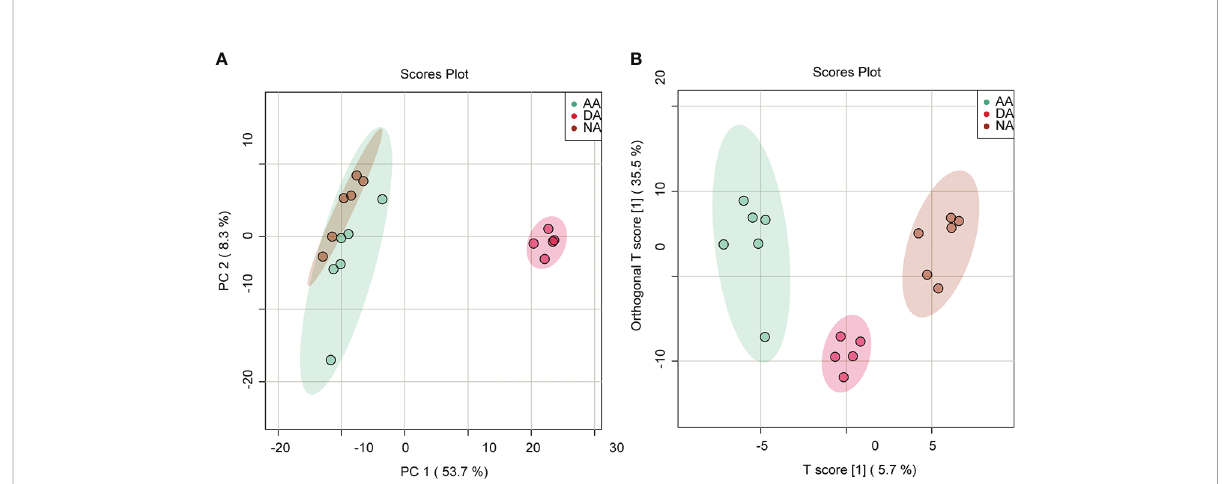
FIGURE 2 PCA and OPLS-DA score plot from the LC – MS intestinal metabolite pro fi les in A . japonicus during estivation cycles. (A) PCA score plot, (B) OPLS-DA score